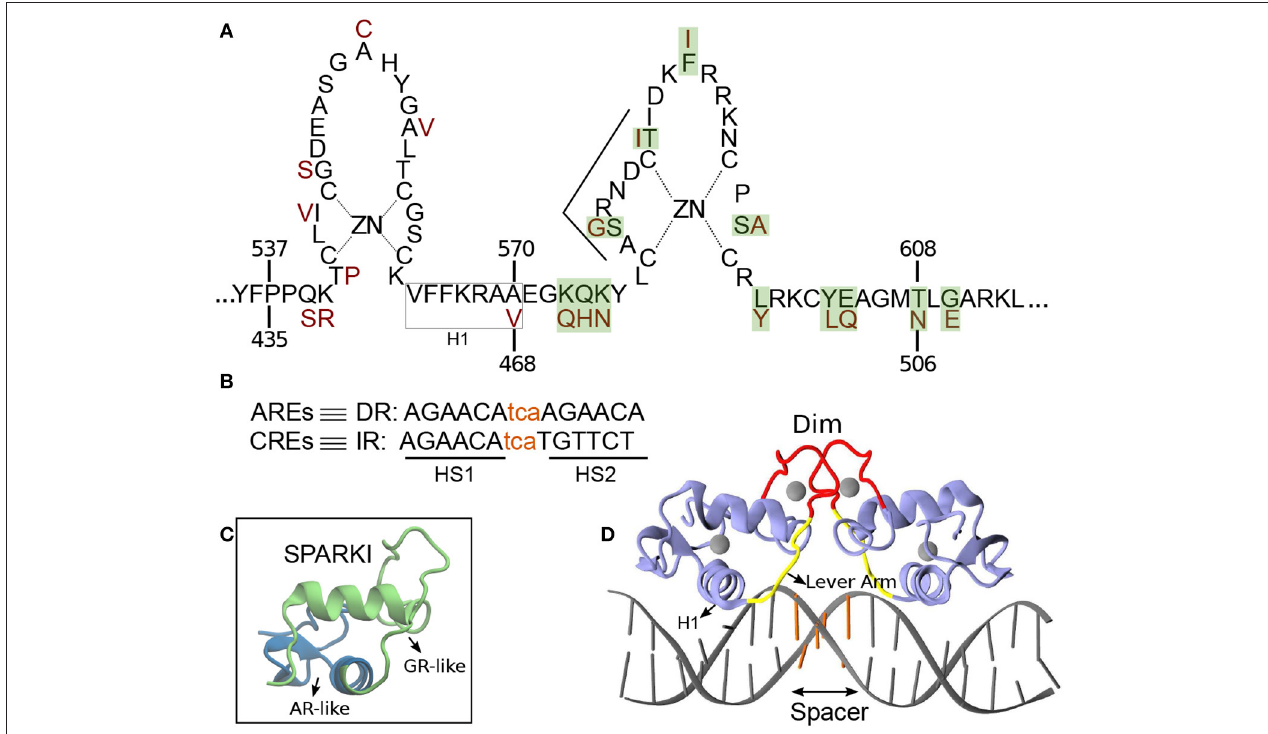
FIGURE 1 | (A) Schematic overview of the DNA binding domain (DBD) sequences in the androgen receptor (AR) and glucocorticoid receptor (GR) protein with corresponding residue numbers above and below, respectively. The amino acids colored in dark red are those elements of the GR-DBD that differ from the AR-DBD sequence. The other amino acids are the same in the AR- and GR-DBD. The amino acids shown with green shadow are those elements in AR that are replaced with residues from GR in order to make Sparki (Schauwaers et al., 2007). (B) DNA sequences for direct (DR) and inverted repeats (IR). The non-capital letters are the spacer base-pairs, colored in orange. (C) Schematic 3D structure of one monomer of Sparki-DBD, regions colored in green and blue are those subdomains that are GR- and AR-like, respectively. (D) The 3D structure of the GR- DBD/DNA complex (pdb ID: 1R4R). A similar structure exists for the AR-DBD/DNA complex (pdb ID: 1R4I). The lever arm and dimerization domain (Dim) are shown in yellow and red, respectively. The spacer region of the DNA is colored with